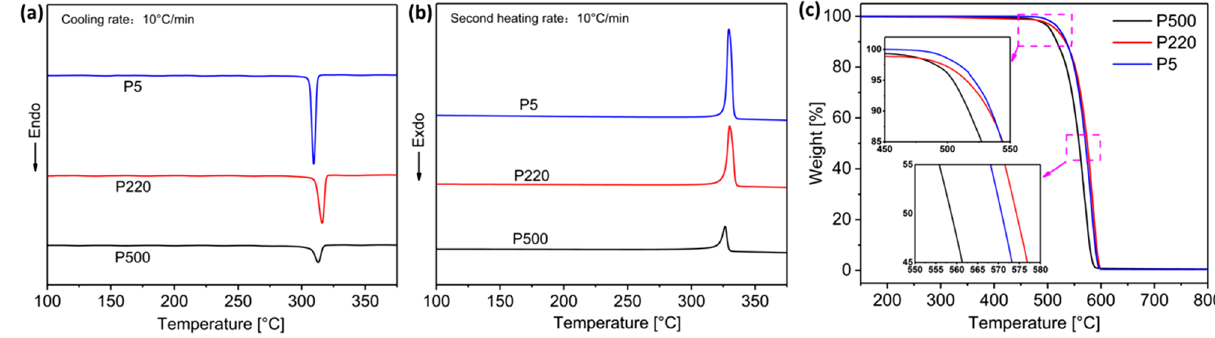
Figure 3. DSC curves of PTFE powders: ( a ) cooling, ( b ) second heating, and ( c ) TGA curves.